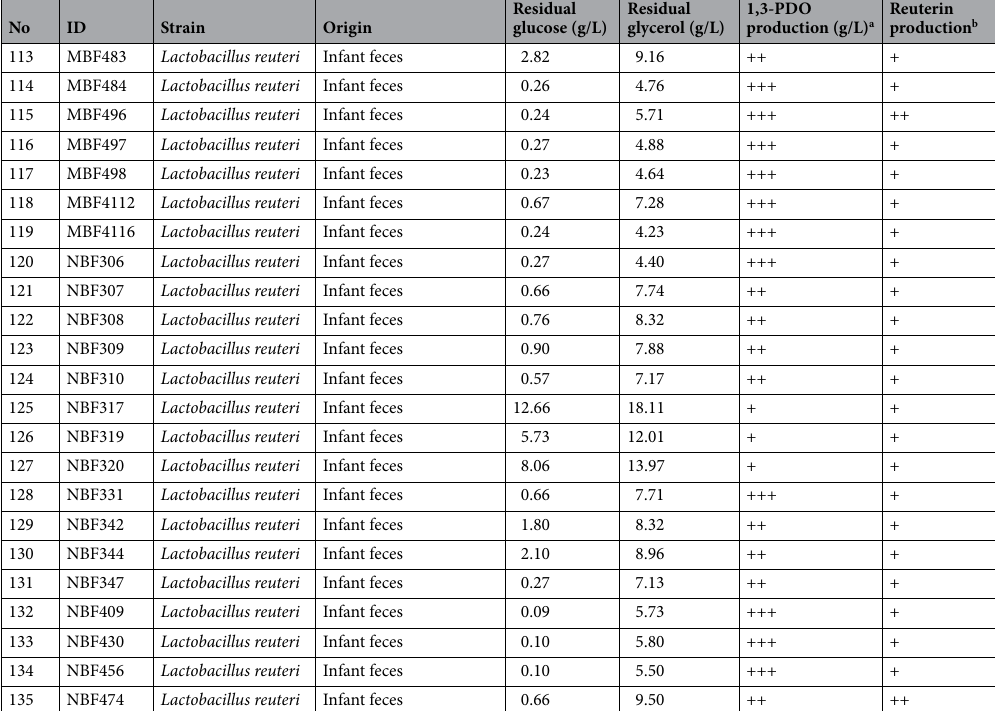
Table 1. Isolation of Lactobacillus reuteri strains, and determination of 1,3-PDO and reuterin production. 1,3- PDO and reuterin production were determined in Lactobacillus reuteri isolates using HPLC and Colorimetric method, respectively. a 1,3-PDO production:+++; > 12 g/L,++; > 7 g/L,+; > 0 g/L, –; not detected. b Reuterin production:+++; > 0.5 at 560 nm,++; > 0.3 at 560 nm,+; > 0.1 at 560 nm, –; not